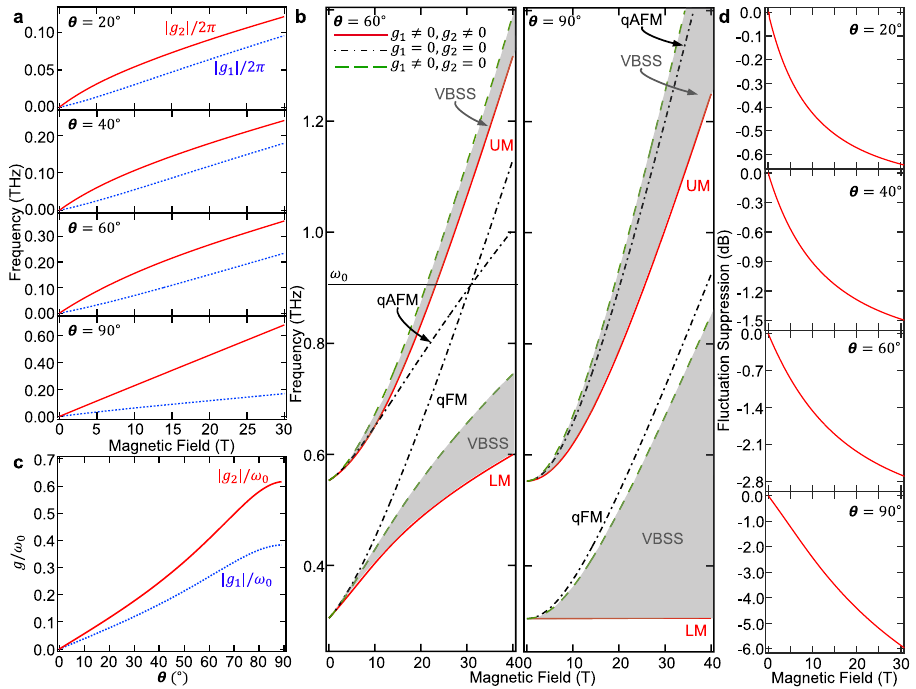
Fig. 4 Extreme breakdown of rotating-wave approximation and vacuum squeezing. a Co-rotating ( ∣ g 1 ∣ /2 π , blue dotted line) and counter-rotating ( ∣ g 2 ∣ /2 π , red solid line) coupling strengths for θ = 20 ∘ , 40 ∘ , 60 ∘ , 90 ∘ displaying dominance of the counter-rotating term. b Theoretical illustration of the quasi-ferromagnetic (qFM) mode, quasi-antiferromagnetic (qAFM) mode, lower mode (LM), upper mode (UM), and co-rotating coupled magnon frequencies that are obtained by setting g 2 = 0, for θ = 60 ∘ and 90 ∘ . The vacuum Bloch – Siegert shifts (VBSSs) are highlighted by the shaded area. c Normalized co-rotating ( ∣ g 1 ∣ / ω 0 , blue dotted line) and counter-rotating ( ∣ g 2 ∣ / ω 0 , red solid line) coupling strengths displaying ultrastrong magnon – magnon coupling and dominance of the counter-rotating terms (CRTs). ω 0 is the frequency at which the qFM and qAFM modes cross, as illustrated in b . d Fluctuation suppression in ^ X ^ c ; ϕ evaluated in the ground state of the coupled magnon system for θ = 20 ∘ , 40 ∘ , 60 ∘ , and 90 ∘ demonstrating squeezing. For θ = 90 ∘ , suppression reaches 5.9 dB for 30